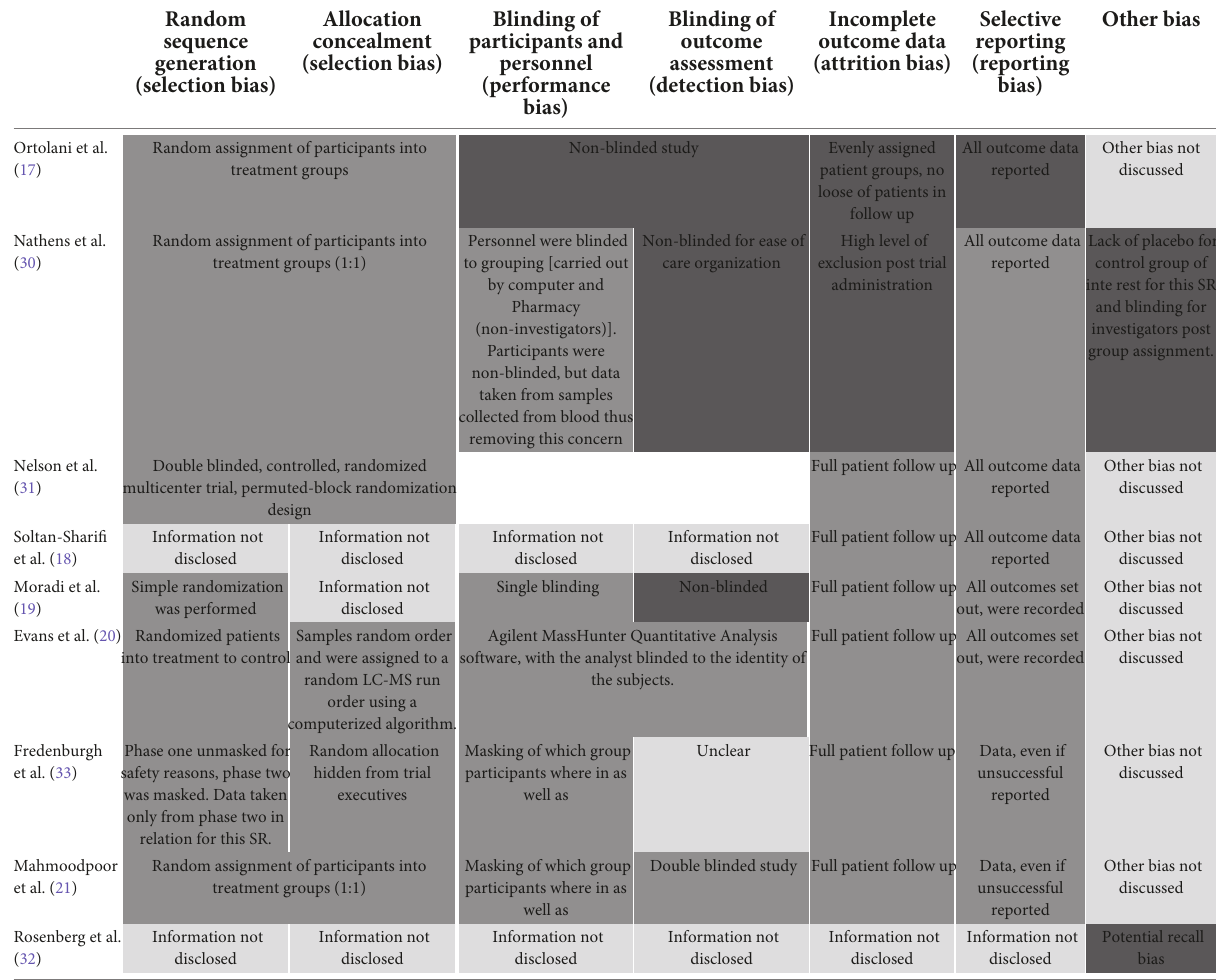
TABLE 6 Quality assessment Cochrane risk of bias table justifications for RCT trial